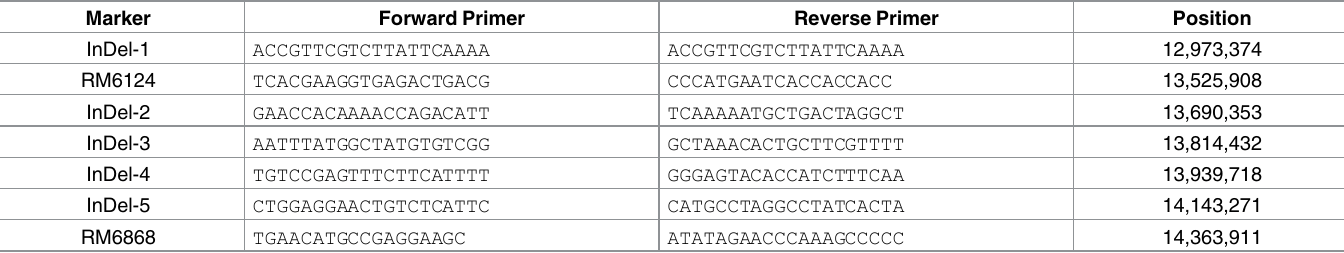
Table 3. Polymorphism markersused for genetic mapping of LESR